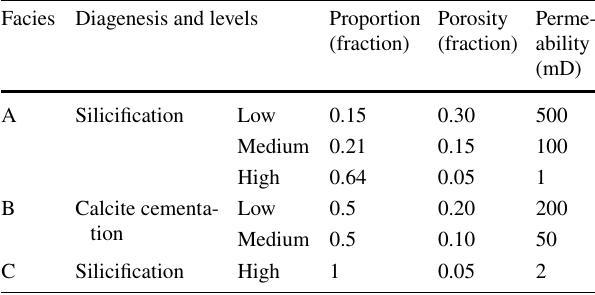
Table 2 Characteristics of diagenesis per facies: proportions, porosi- ties and permeabilities Facies Diagenesis and levels Proportion